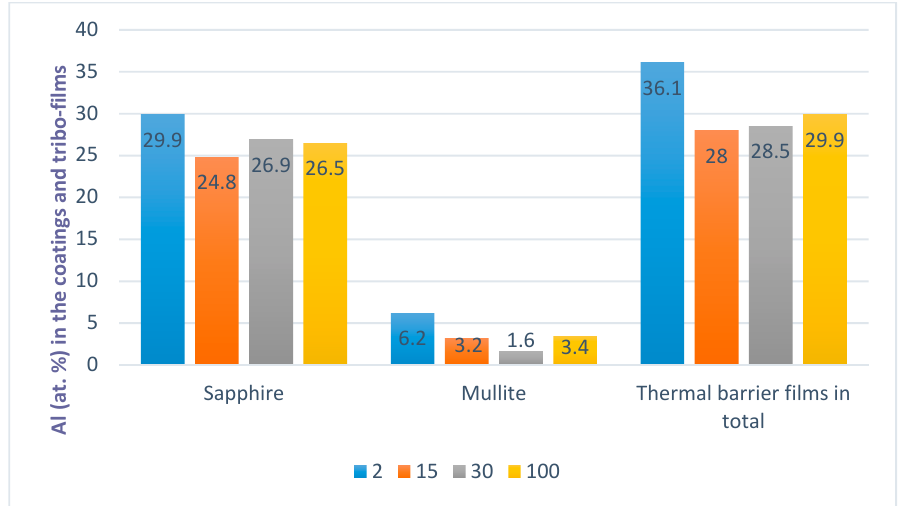
Figure 4. XPS data on the tribo-films formation vs. length of cut. Amount of tribo-films vs. length of cut: 2; 15; 30; 100 m [49].